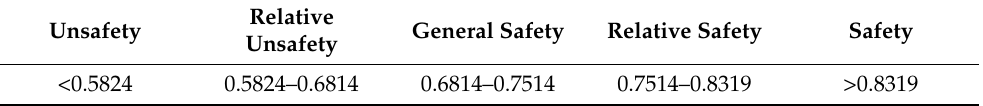
Table 4. The classification standard of ES pattern of urban agglomeration in